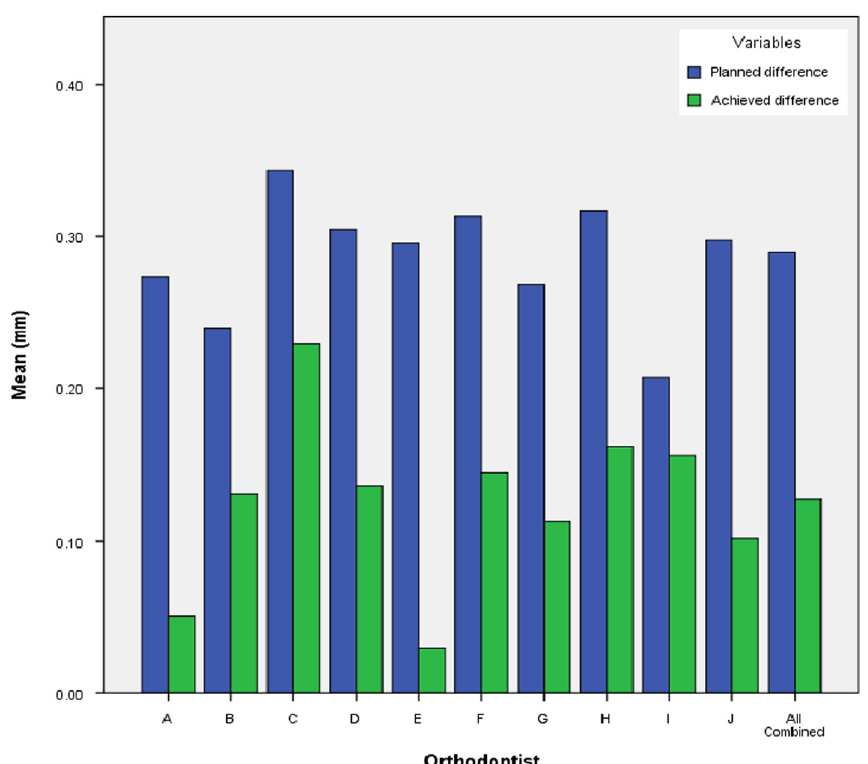
Figure 5. Showing planned and achieved tooth width changes across all